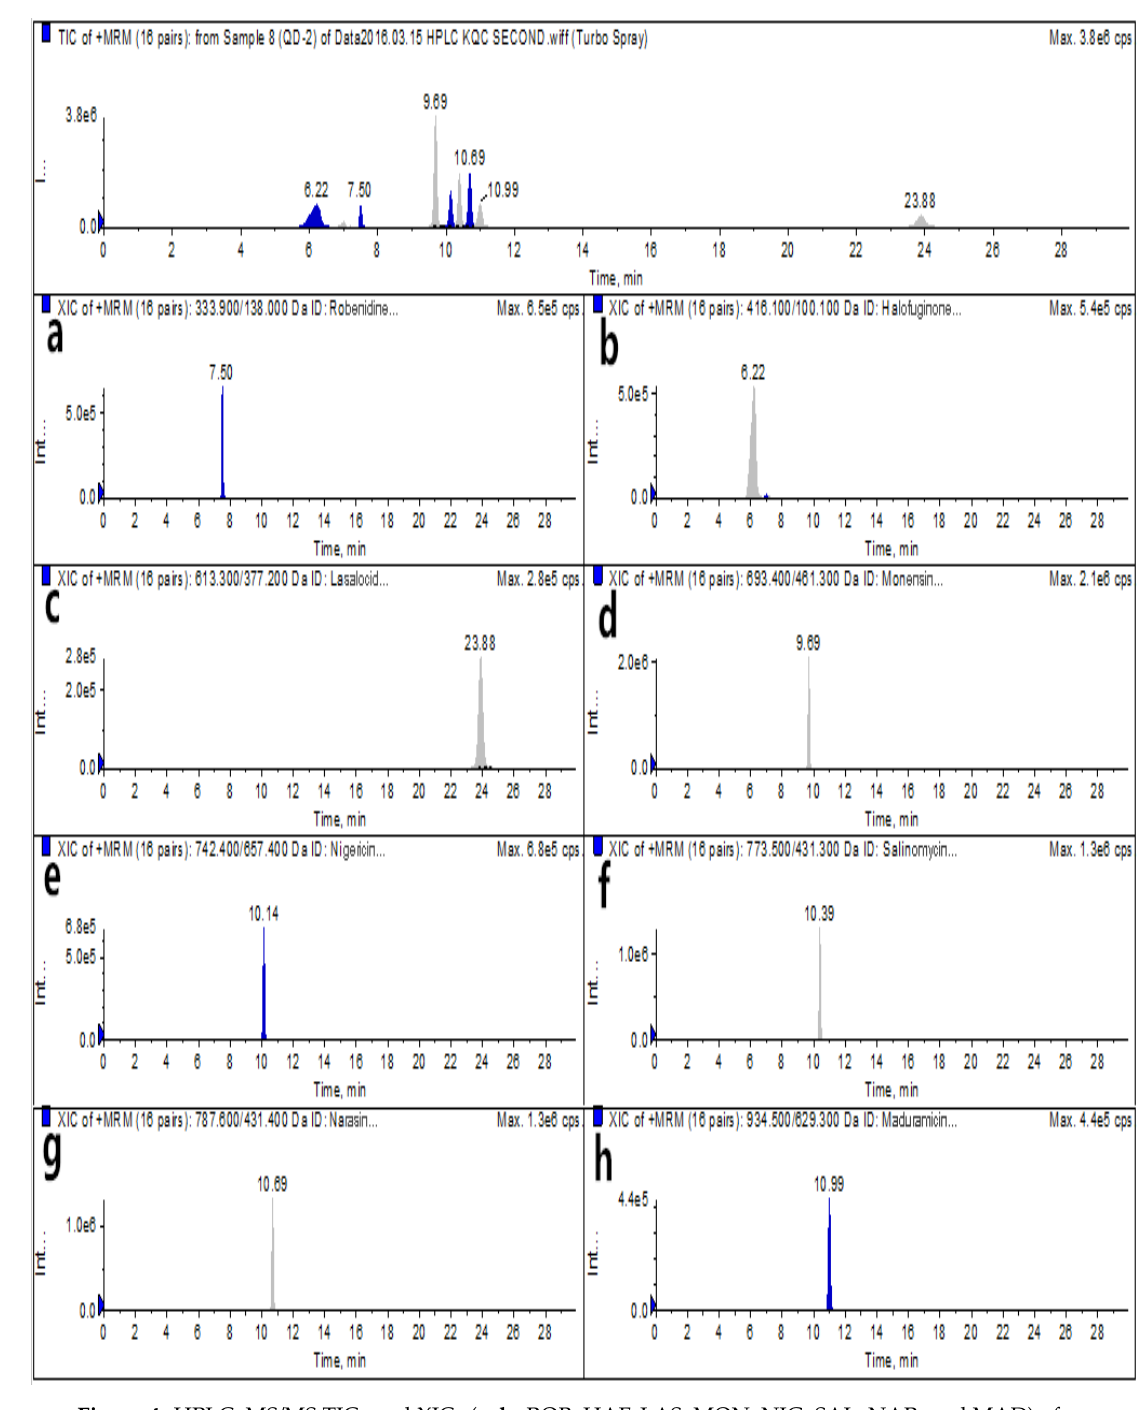
Figure 4. HPLC–MS / MS TICs and XICs ( a – h : ROB, HAF, LAS, MON, NIG, SAL, NAR, and MAD) of a Figure 4. HPLC–MS/MS TICs and XICs ( a – h : ROB, HAF, LAS, MON, NIG, SAL, NAR, and MAD) of blank egg sample spiked with ROB and HAF at 25.0 µ g / kg, MON at 37.5 µ g / kg, MAD at 60.0 µ g / kg, a blank egg sample spiked with ROB and HAF at 25.0 µg/kg, MON at 37.5 µg/kg, MAD at 60.0 µg/kg, and LAS, NIG, SAL, and NAR at 15.0 µ g / and LAS, NIG, SAL, and NAR at 15.0 µg/kg.